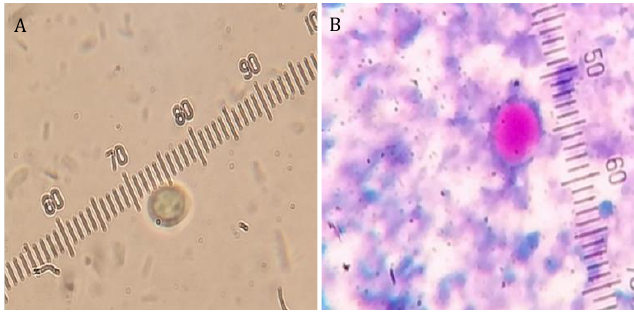
Figure 1. (A) Morphology of Cryptosporidium spp. oocyst using Sheather's sugar solution (B) Rapid dimethyl dulfoxide-modified acid-fast stain